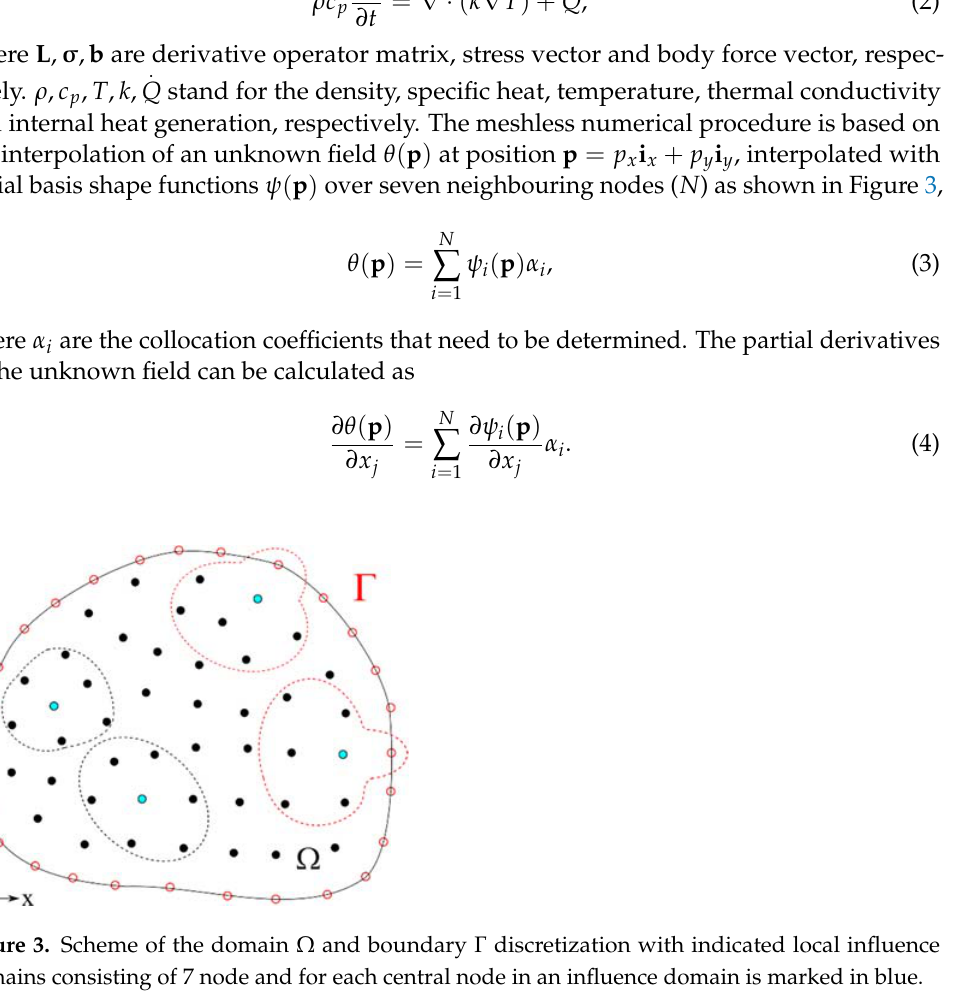
4 of 26 Figure 2. Picture of one-way macro-micro coupling.